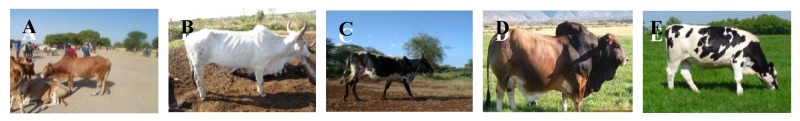
Photographs of individuals representing the Tanzania cattle populations and breeds involved in the present study.A: Sukuma B. Tarime C. Maasai D. Boran E. Friesian (Photo by ELKL).